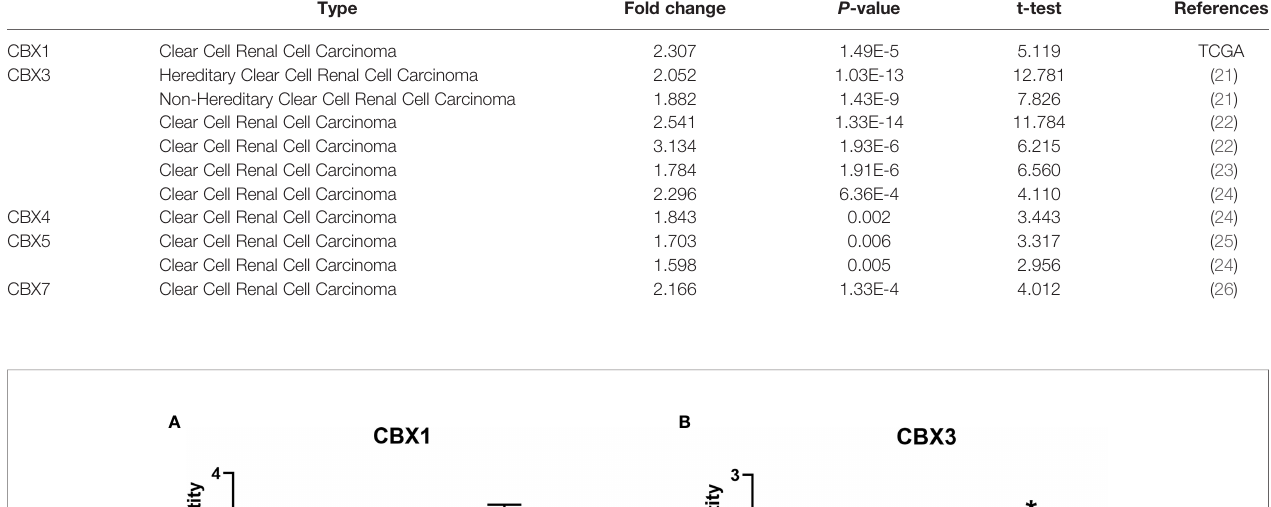
TABLE 1 | The signi fi cant changes of CBXs expression in transcription level between ccRCC and normal kidney tissues (Oncomine). Type Fold change